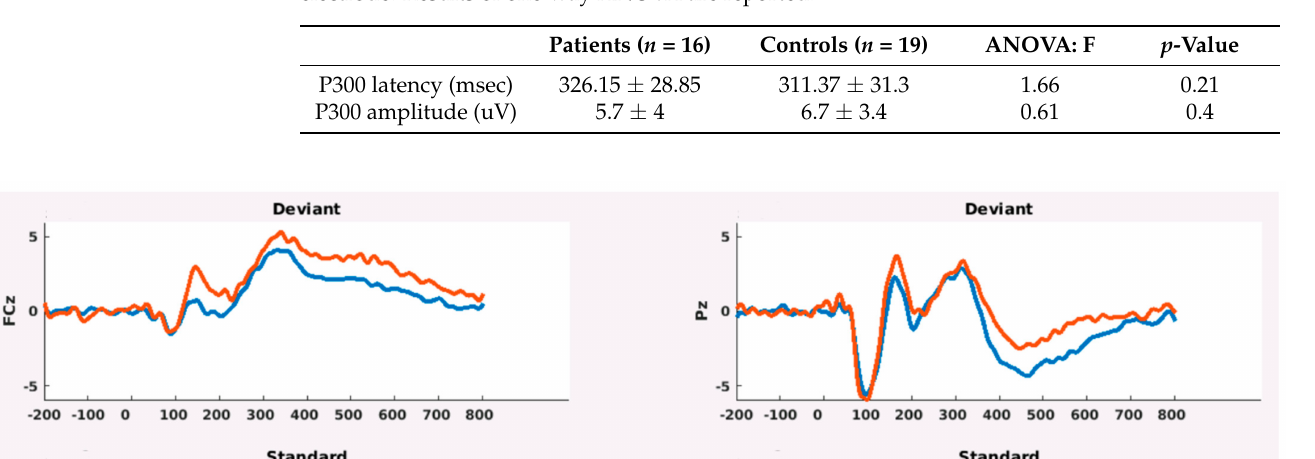
Table 4. Mean values and standard deviation of P300 amplitude and latency measured on Pz electrode. Results of one-way ANOVA are reported.